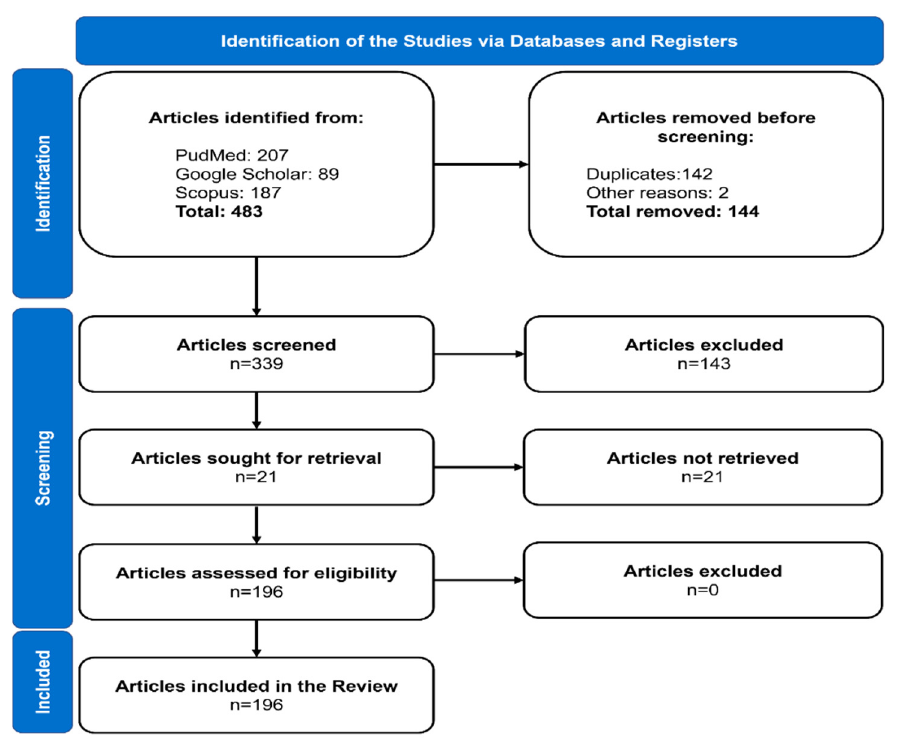
Figure 1. Summary of selection of studies process by following the PRISMA guidelines.